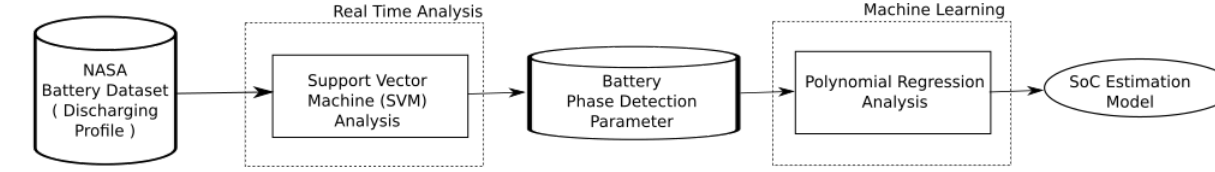
Figure 1. Experiment Setup.